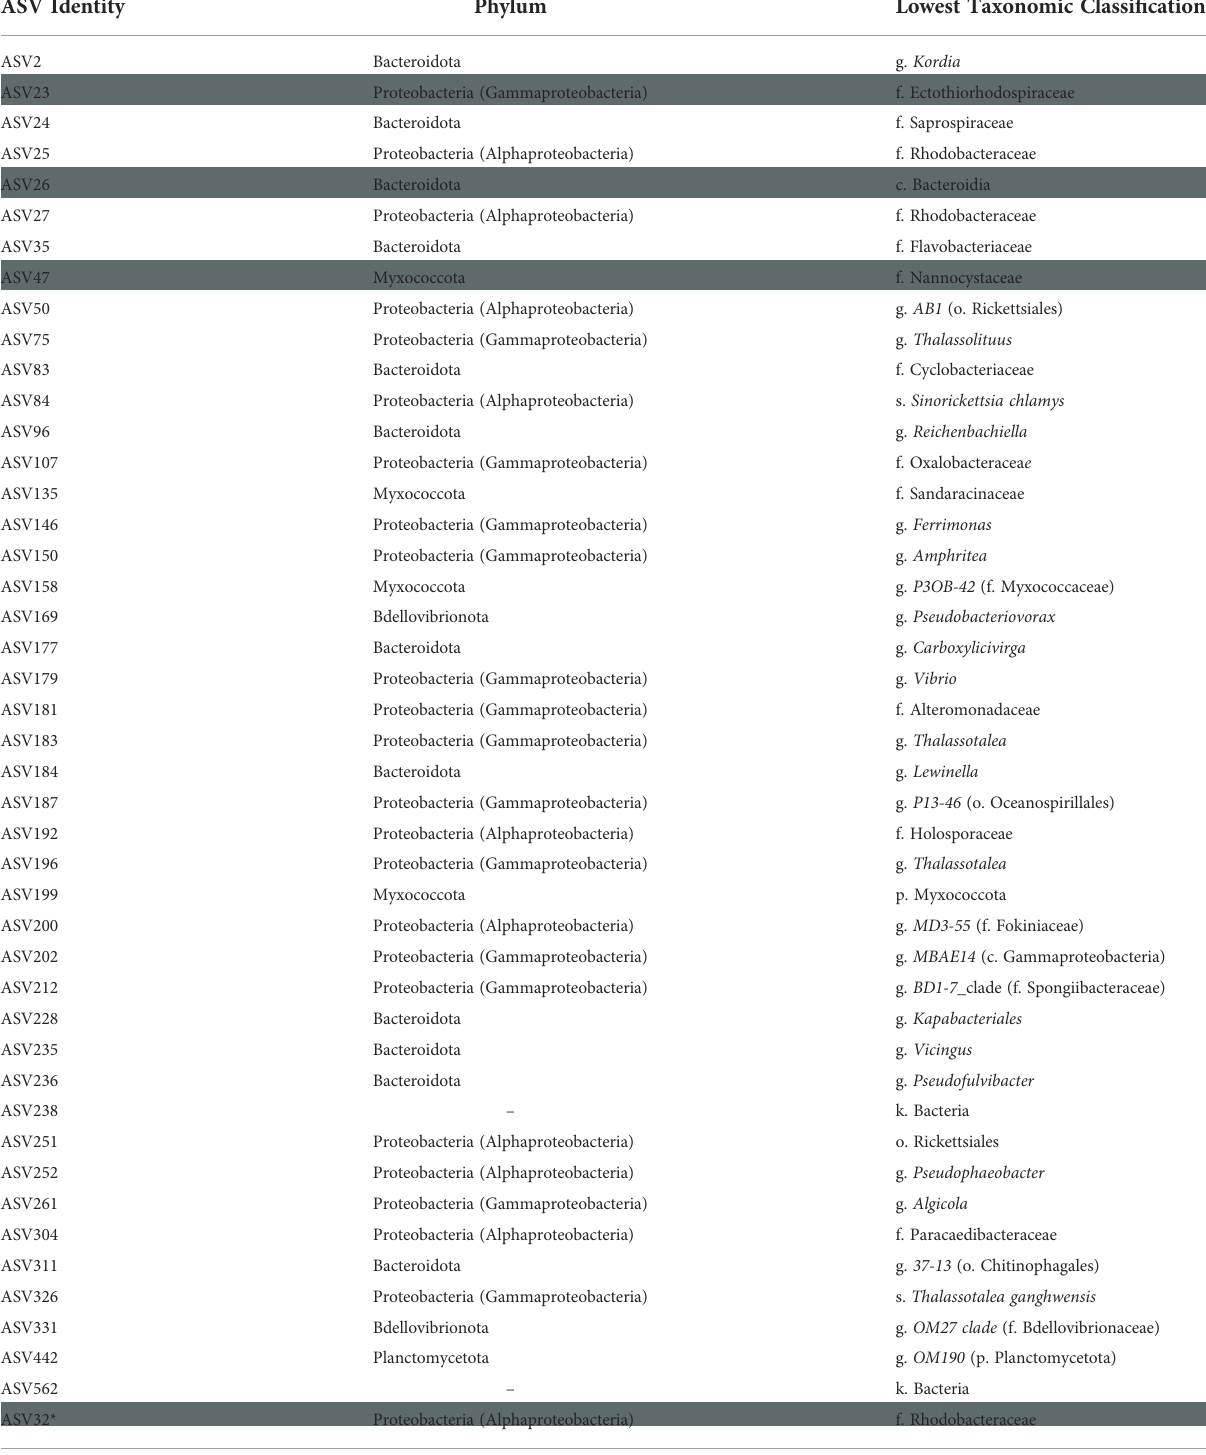
TABLE 3 Bio fi lm amplicon sequence variants (ASVs) that were both obligate (present in at least 70% of diseased samples) and speci fi c (found only in diseased samples). ASV